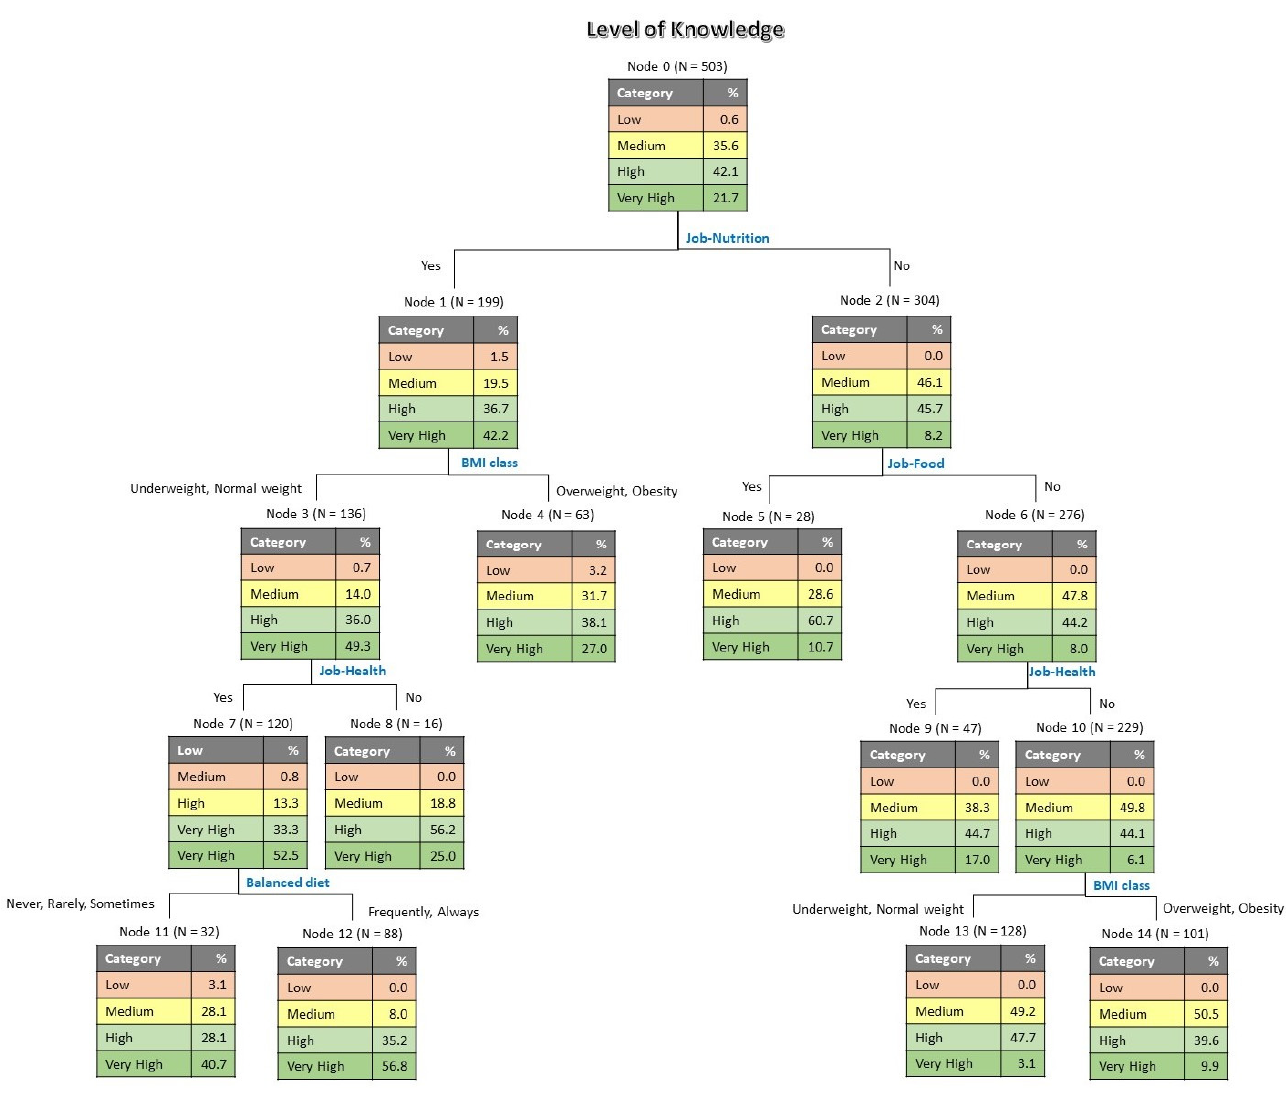
Figure 2. Tree classification for level of knowledge as influenced by other variables, professional areas, BMI, and practice of balanced diet.